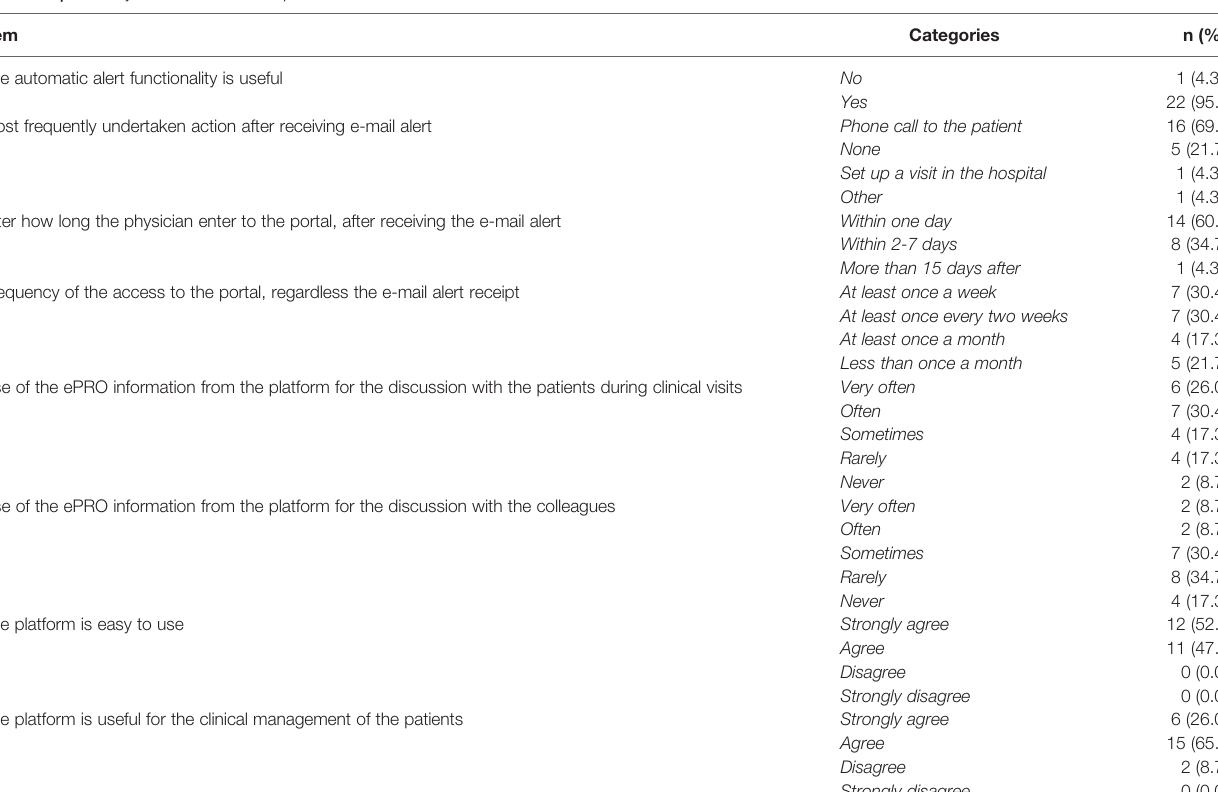
TABLE 1 | Usability and bene fi ts of the